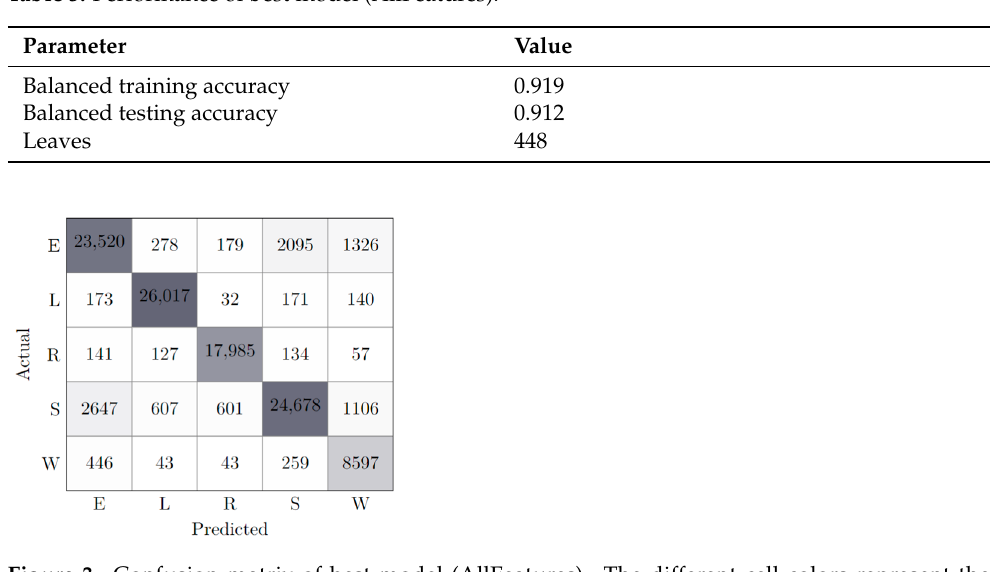
Figure 3. Confusion matrix of best model (AllFeatures). The different cell colors represent the classification accuracy; the more accurate the classification of a state, the darker the cell is represented.